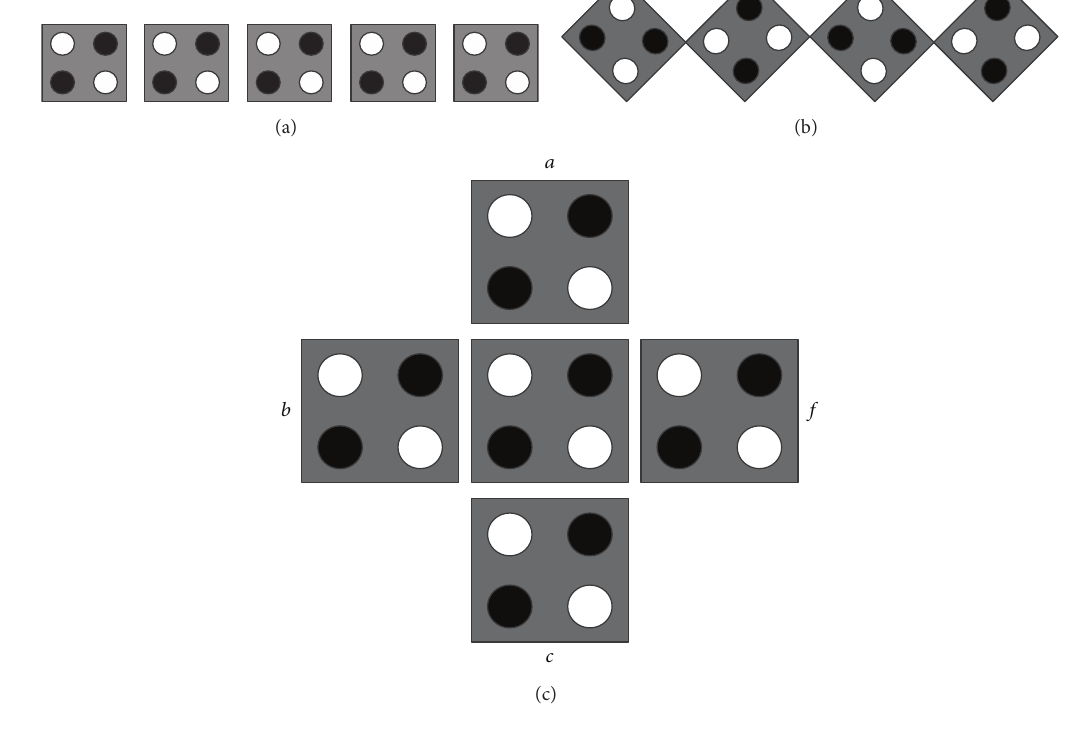
Figure 2: (a) QCA wire (90 ∘ ), (b) QCA wire (45 ∘ ), and (c) QCA majority gate.